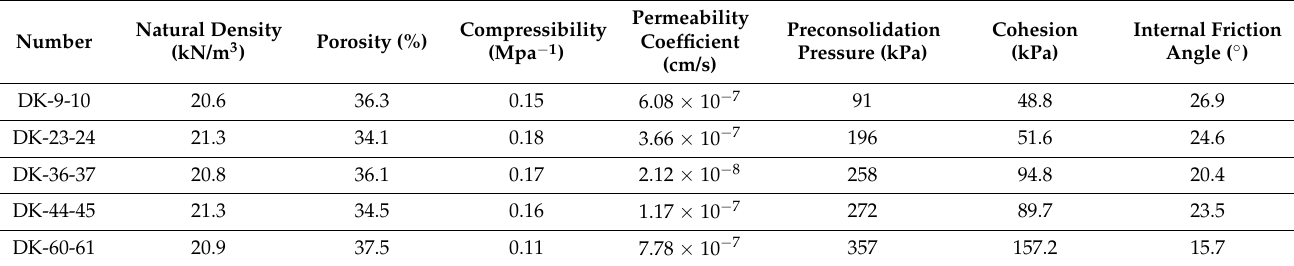
Table 2. Conventional physical and mechanical